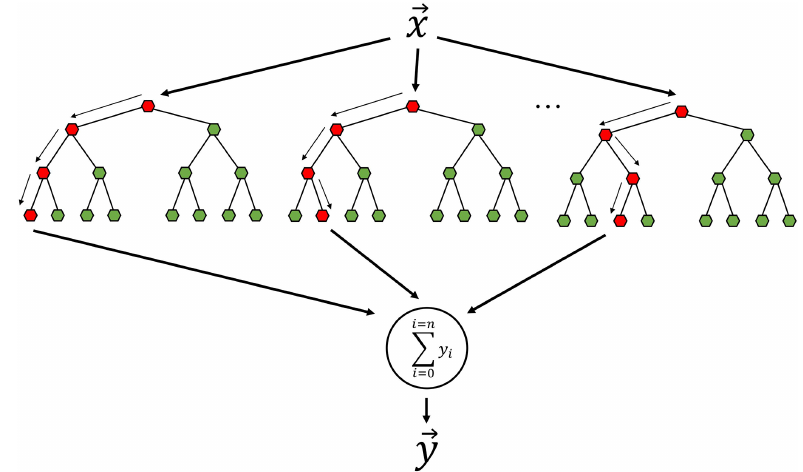
Figure 7. Flowchart of RFR illustrating many uncorrelated trees built using random feature sampling whose average prediction is more accurate than each of the individual trees.